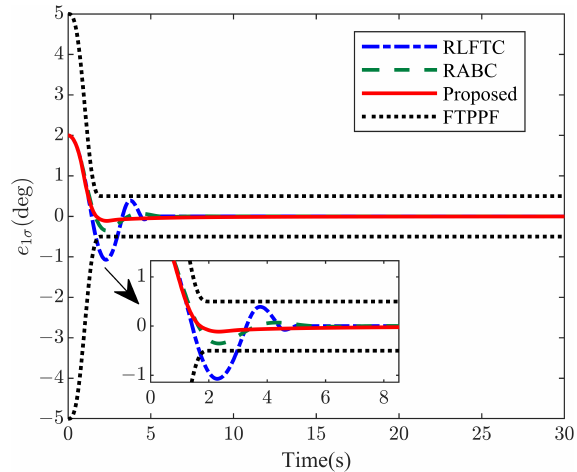
Figure 5. Time histories of the attitude tracking error e 1 σ .